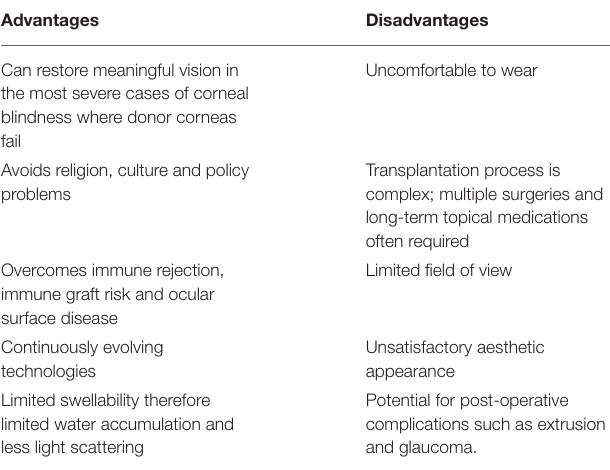
TABLE 1 | Advantages and disadvantages of